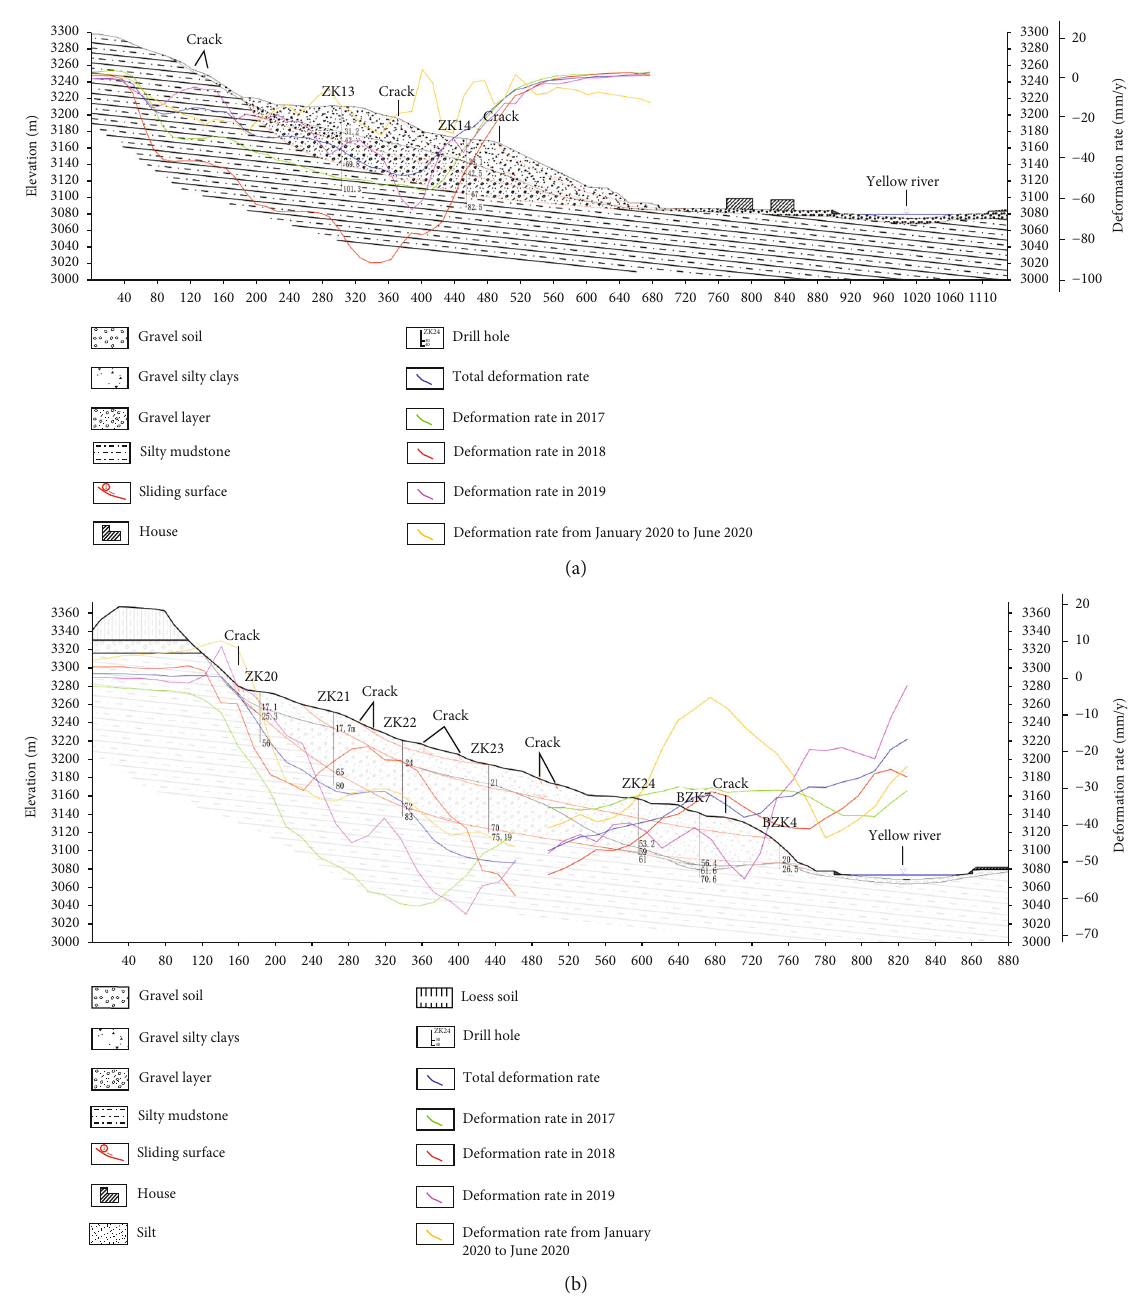
Figure 9: (a) 1-1 ′ InSAR deformation pro fi le. (b) 2-2 ′ InSAR deformation pro fi